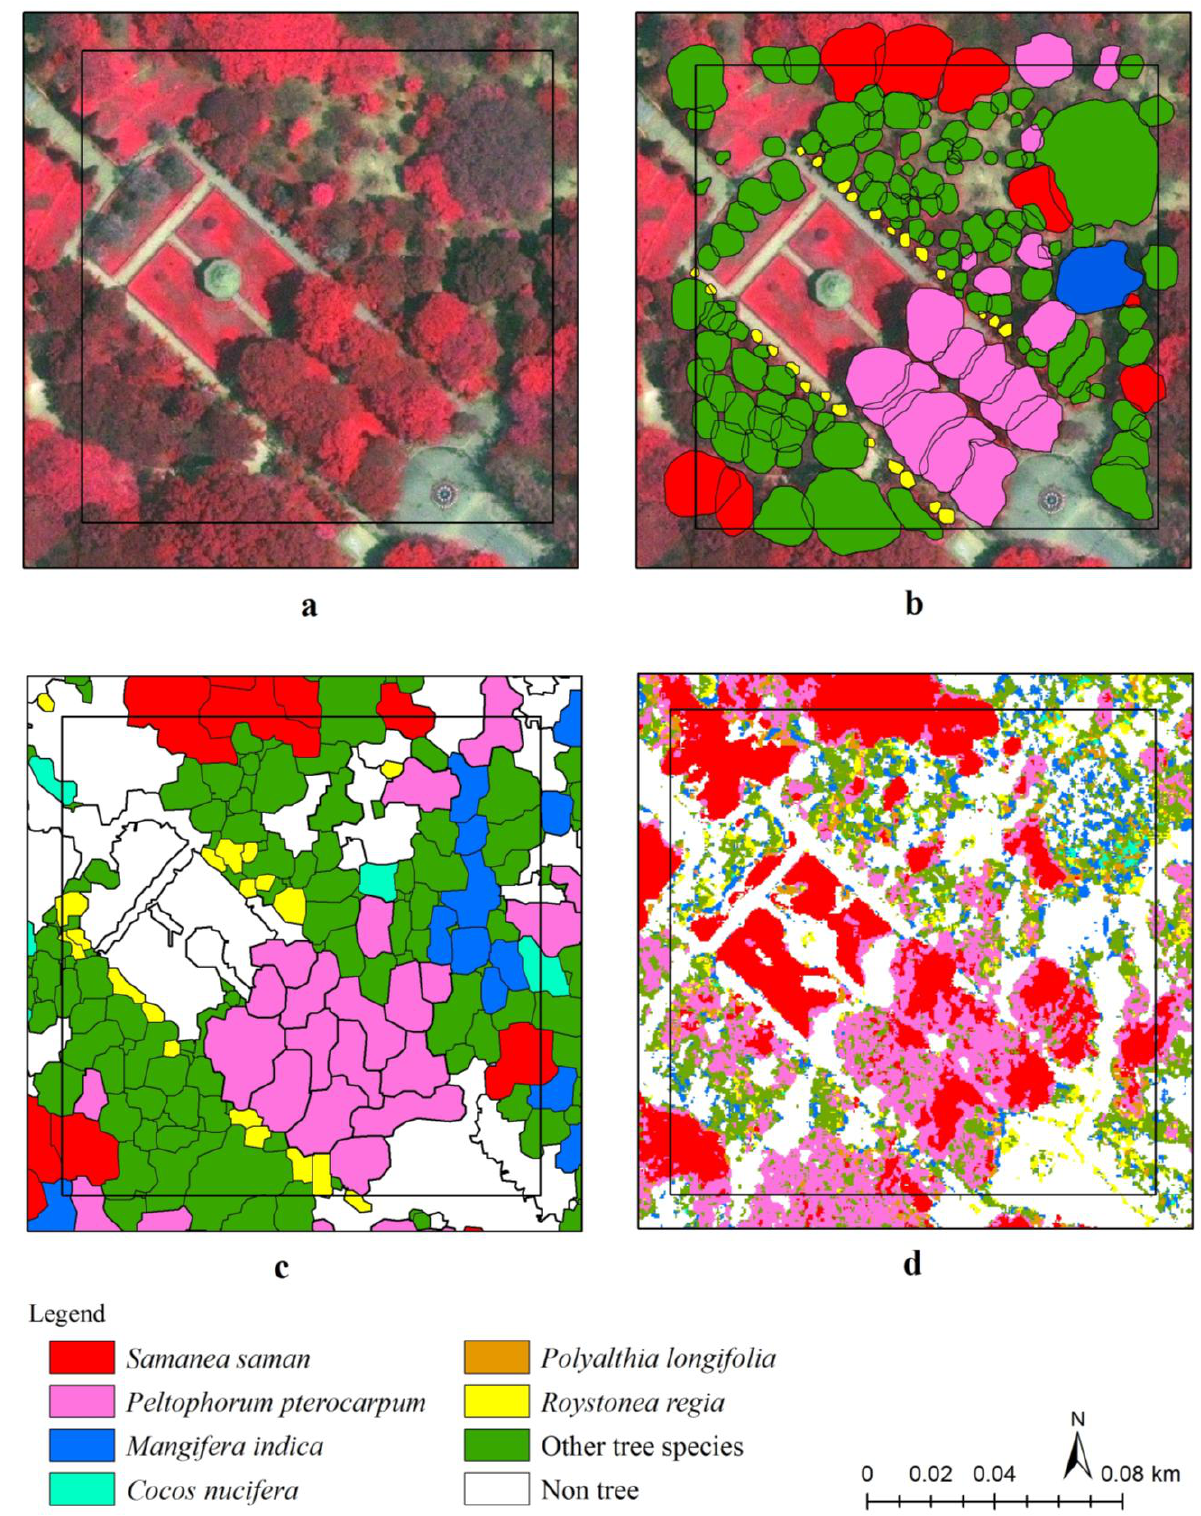
Figure 4. ( a ) False color composite of a grid cell in Cubbon Park. ( b ) Tree species mapped from ground survey. ( c ) Tree species mapped using object-based approach. ( d ) Tree species mapped using pixel-based